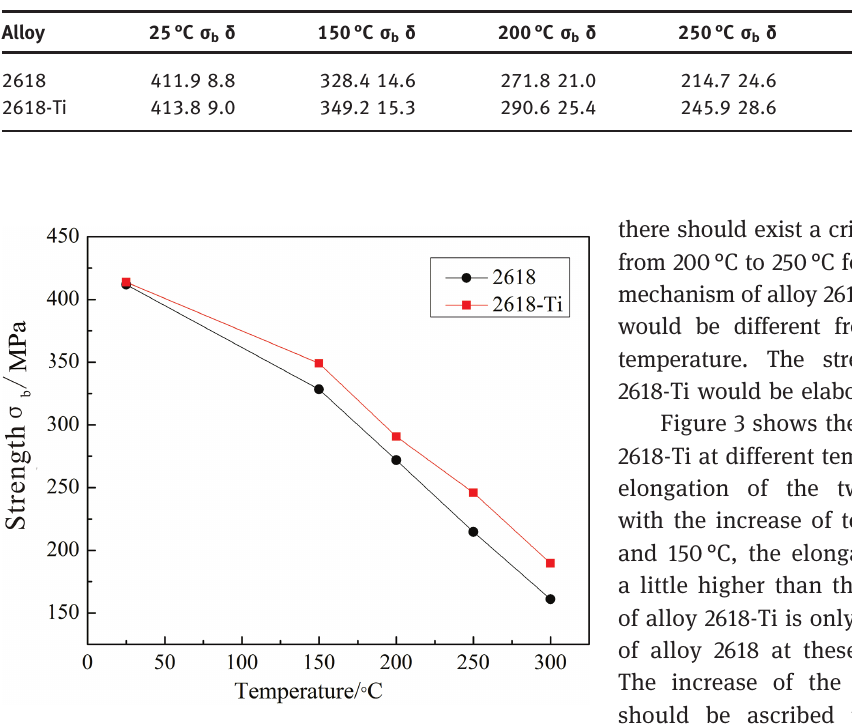
Figure 2: The tensile strength of alloy 2618 and 2618-Ti as a function of temperature.